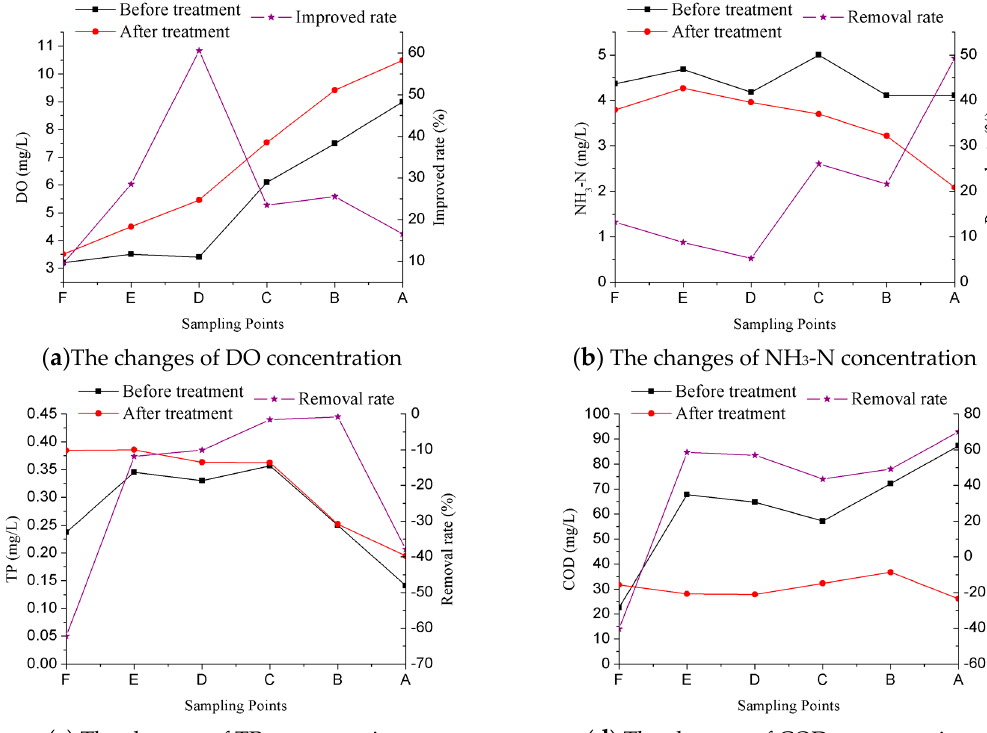
Figure 4. The changes of four major water quality parameters before and after microbial treatment: ( a ) The changes of DO concentration and its improved rate over 18 days; ( b ) The changes of NH 3 -N concentration and its removal rate over 18 days; ( c ) The changes of TP concentration and its removal rate over 18 days; ( d ) The changes of COD concentration and its removal rate over 18 days.